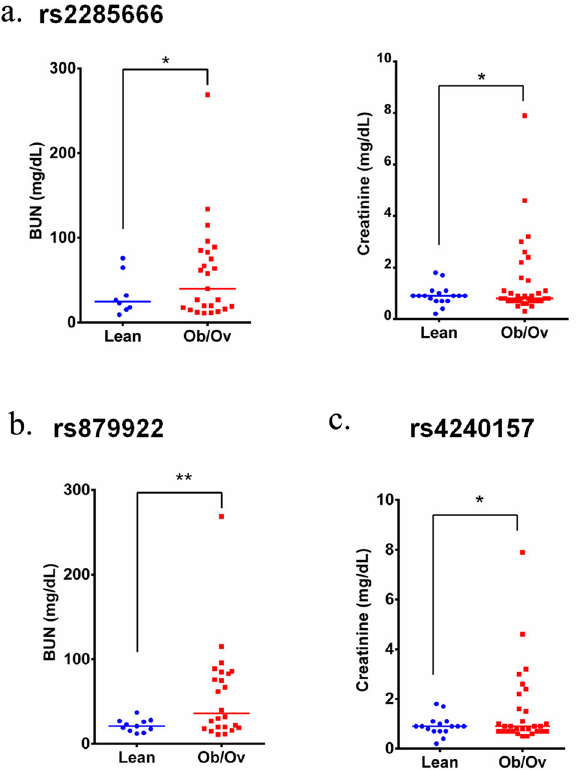
Figure 8. Significant association between ACE2 variants and blood biomarkers in COVID-19 obese patients. Creatinine and BUN levels are significantly increased in COVID-19 patients obese patients expressing ( a ) rs2285666, ( b ) rs879922, and ( c ) rs4240157 variants as compared to their lean counterparts. * p < 0.05; ** p <